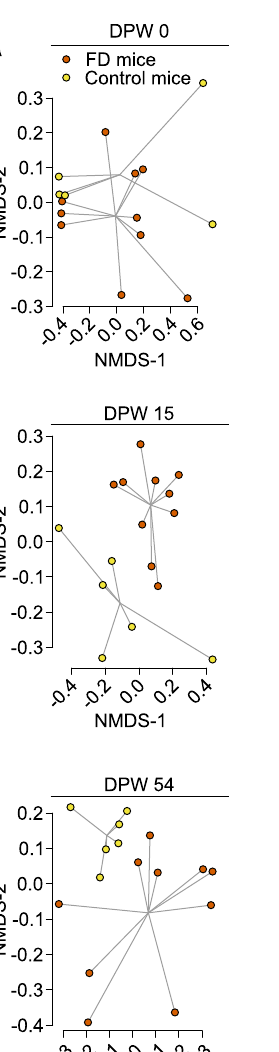
stool metabolome in mice at 162 DPW. n = a , b , c 10 FD mice (4 female, 6 male; 3 cages),6controlmice(4female,2male;2cages); d ,12FDmice,13controlmice(all female;3cagespergenotype);PERMANOVA( a , b , day0,df=1, R 2 =0.1099;day 15, df=1,R 2 =0.1664;day25,df=1,R 2 =0.1458;day40,df=1,R 2